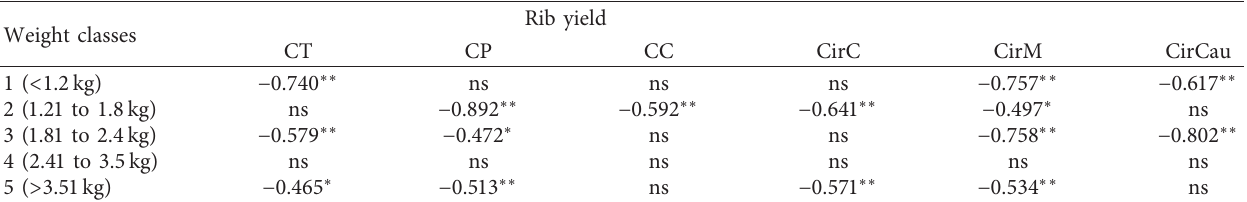
Table 4: Correlations between the rib yield and morphometric measurements in relation to the different weight classes of black pacu ( Colossoma macropomum ).